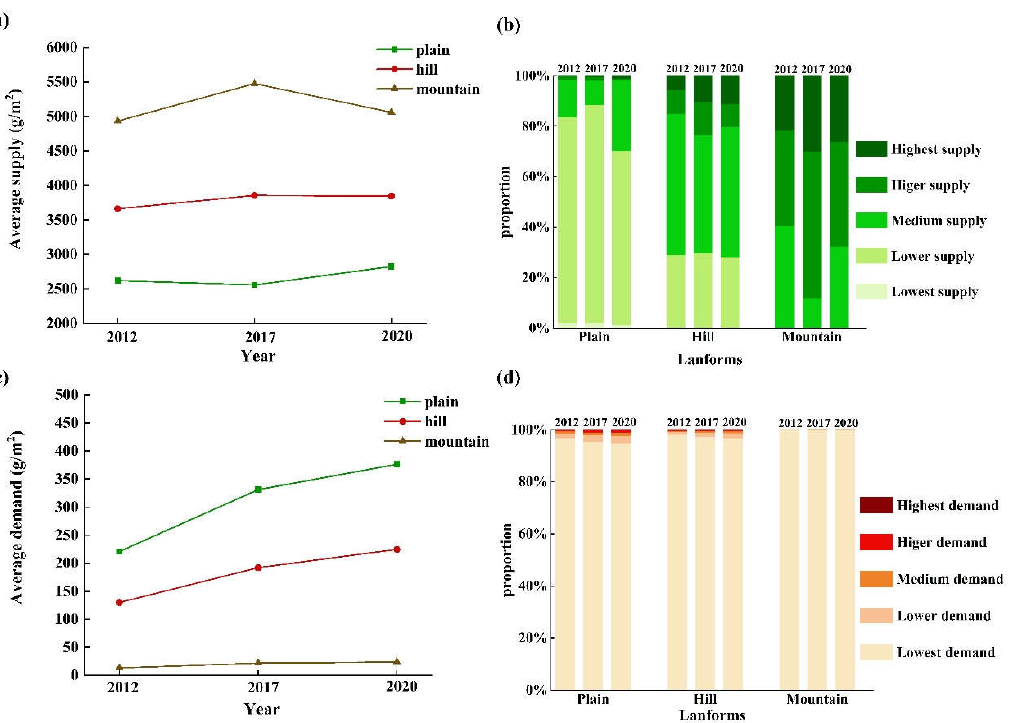
Figure 5. ( a , b ) The temporal variations of the average and frequency for the supply and ( c , d ) demand in different landforms from 2012 to 2020.